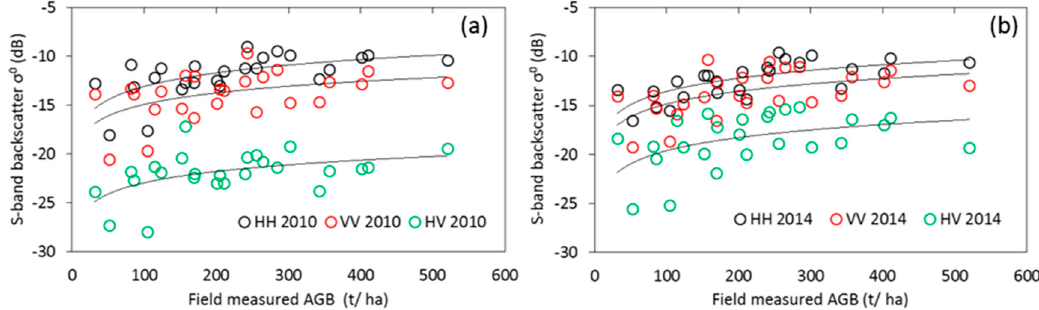
Figure 8. S-band backscatter ( σ °) plotted against field measured AGB (t/ha) for combined sites in 2010 ( a ) and 2014 ( b ).